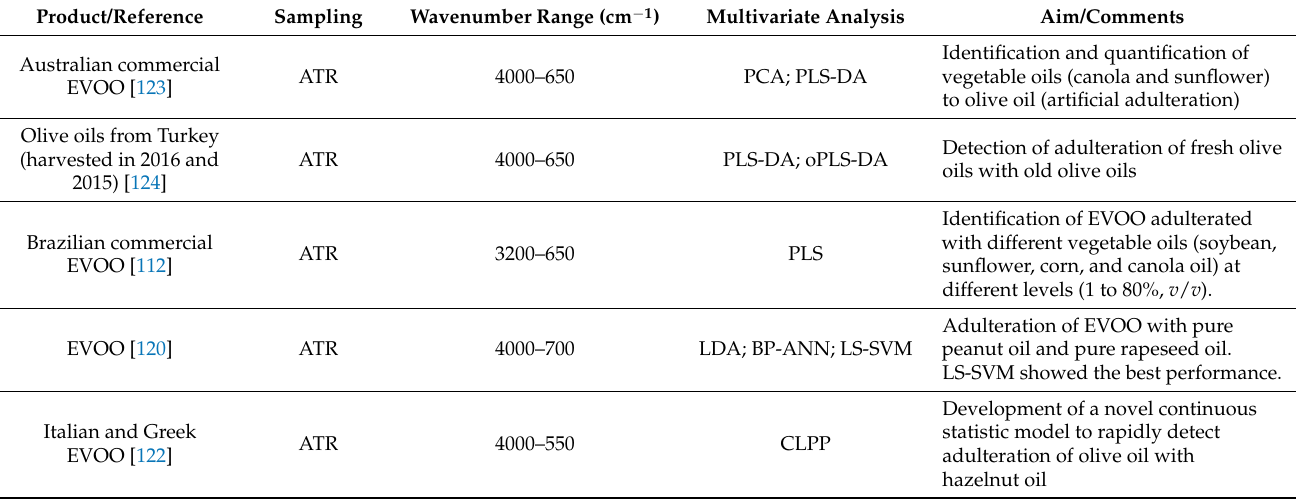
Table 6. Application of FT-MIR spectroscopy to the analysis of olive